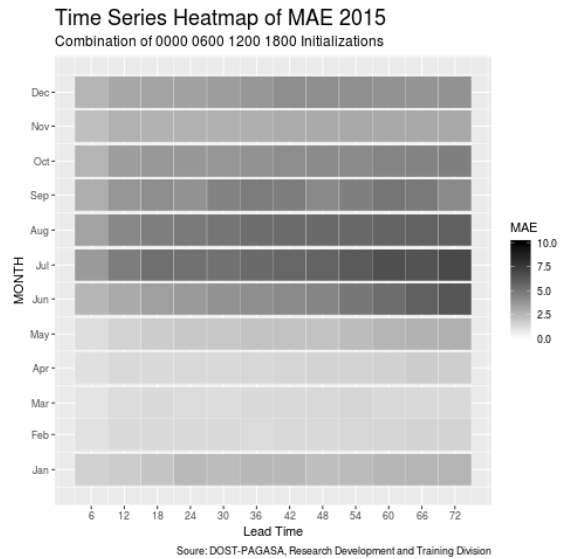
Animated plots used for the geovisual analysis can be found here: shorturl.at/bdorH . The following plots show the resulting verification scores for the yearly performance evaluation of the